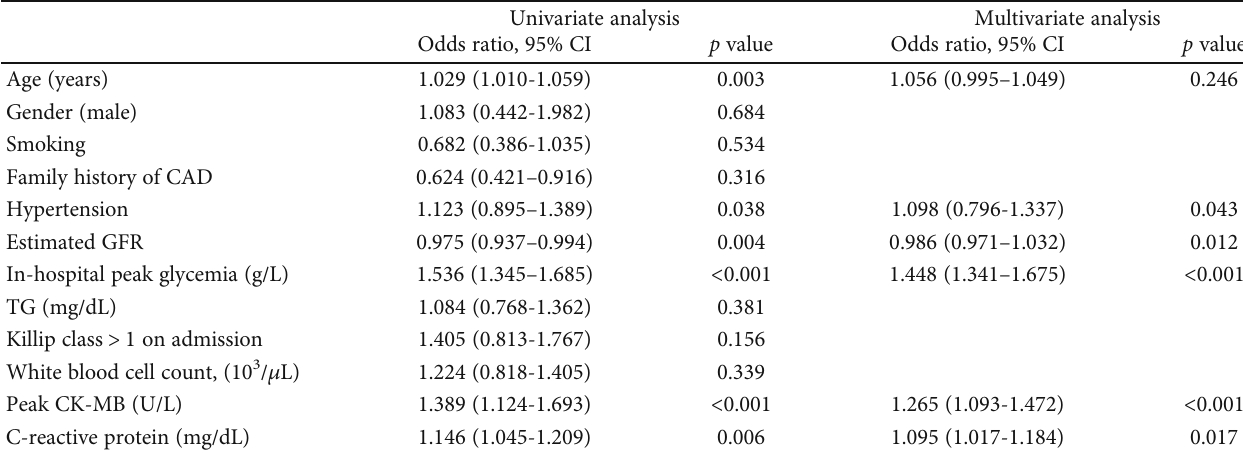
Table 4: E ff ects of various variables on no-re fl ow in univariate and multivariate logistic regression analyses.